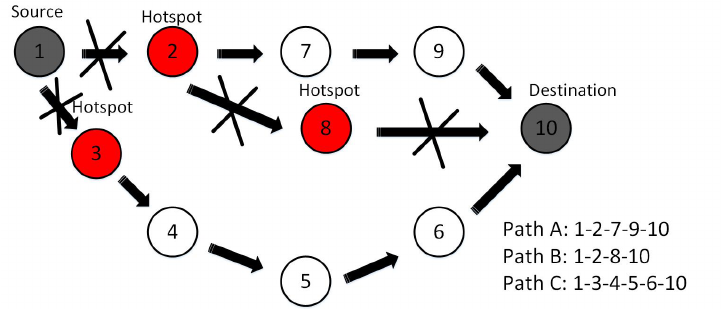
Communication halt in Network: Entire communication has become halted and communication will not be forwarded due to the hotspot